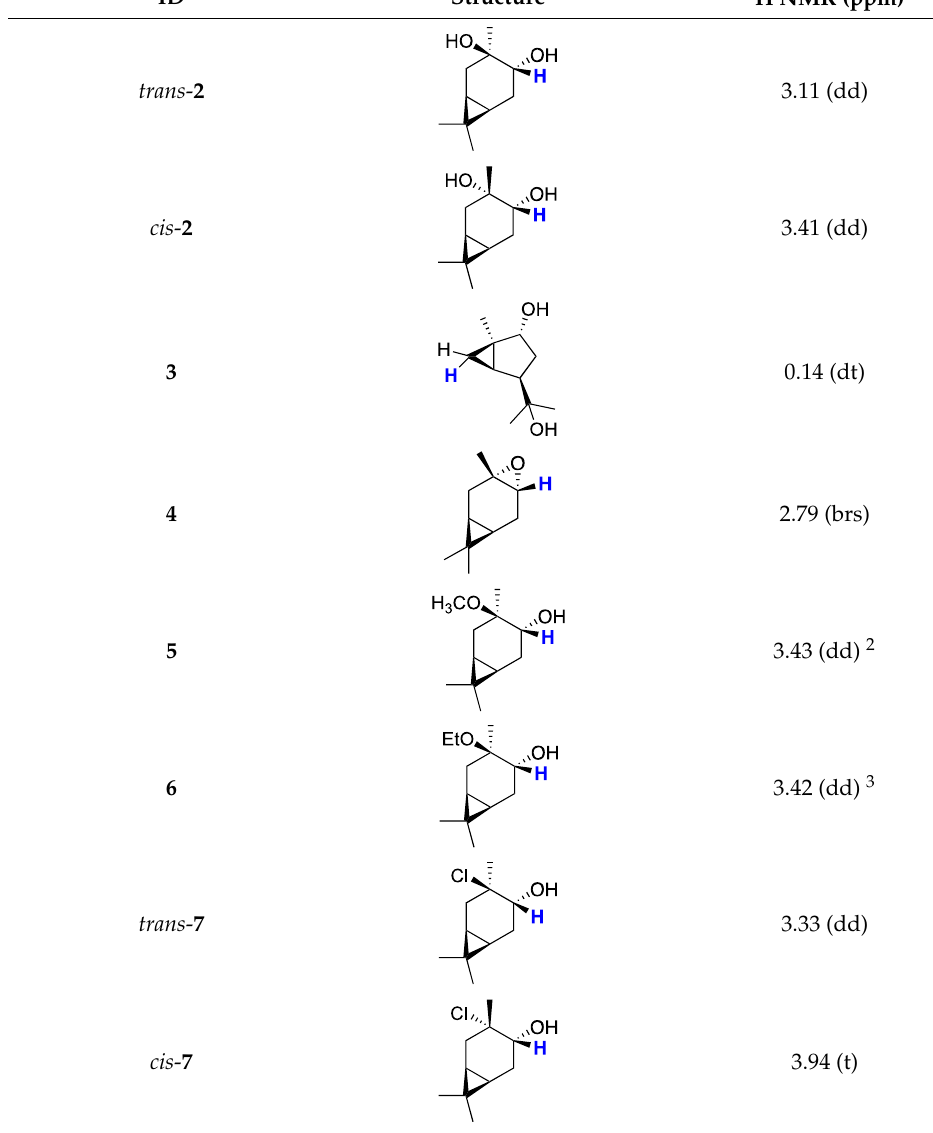
Table 1. Product structures and selected identifying 1 H NMR signals in DMSO- d 6 . 1 Hydrogen atoms corresponding to the identifying signals are indicated in blue.